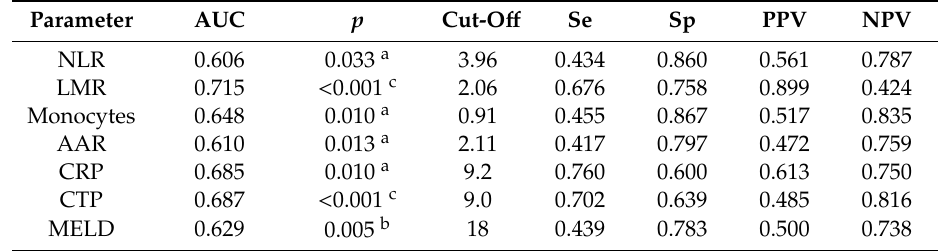
Table 5. Odds ratio for selected predictors.